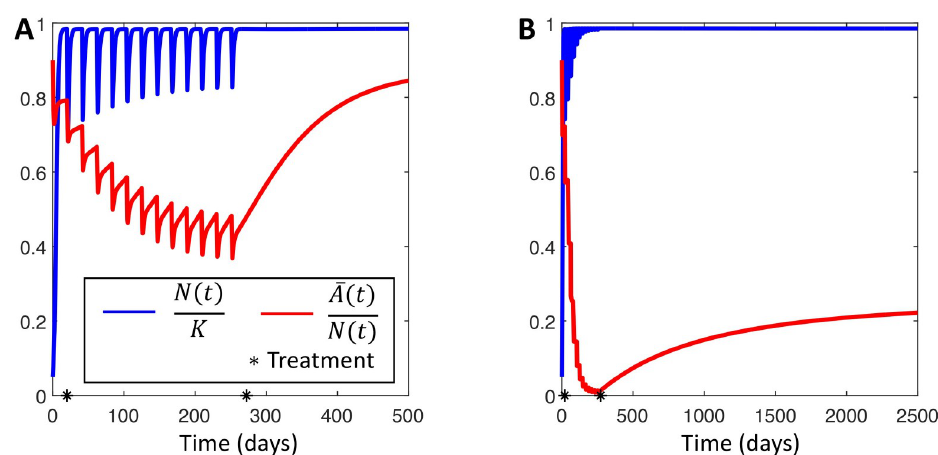
Fig 4. The effect of switching strategy on treatment efficacy. The effect of periodic treatment on a population using either the switch ( A ) or the stay strategy ( B ). Periodic therapy is applied as described in Periodic Treatment Leads to Dominant Phenotype Switches . Therapy is applied between days 50 and 275, marked by the black stars. Red curves show the proportion of sensitive cells � A ð t Þ = N ð t Þ . Blue curves shows the dynamics of the total population as a fraction of the population carrying capacity N ( t )/ K . Model parameters used in these simulations are given in Table A in S1 Text.